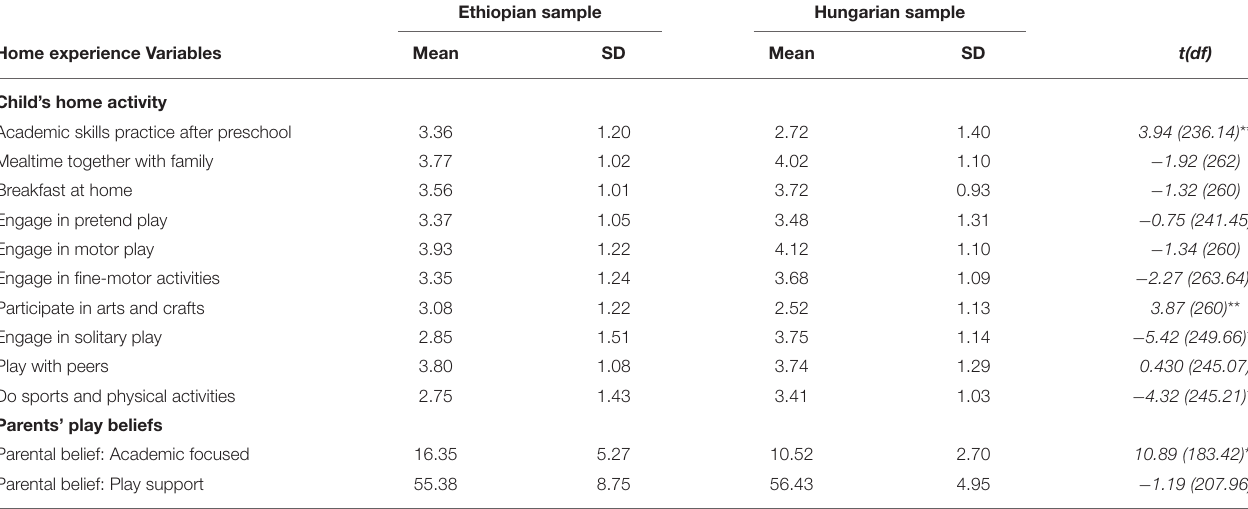
TABLE 3 | T -test statistics for home experience measures between the two